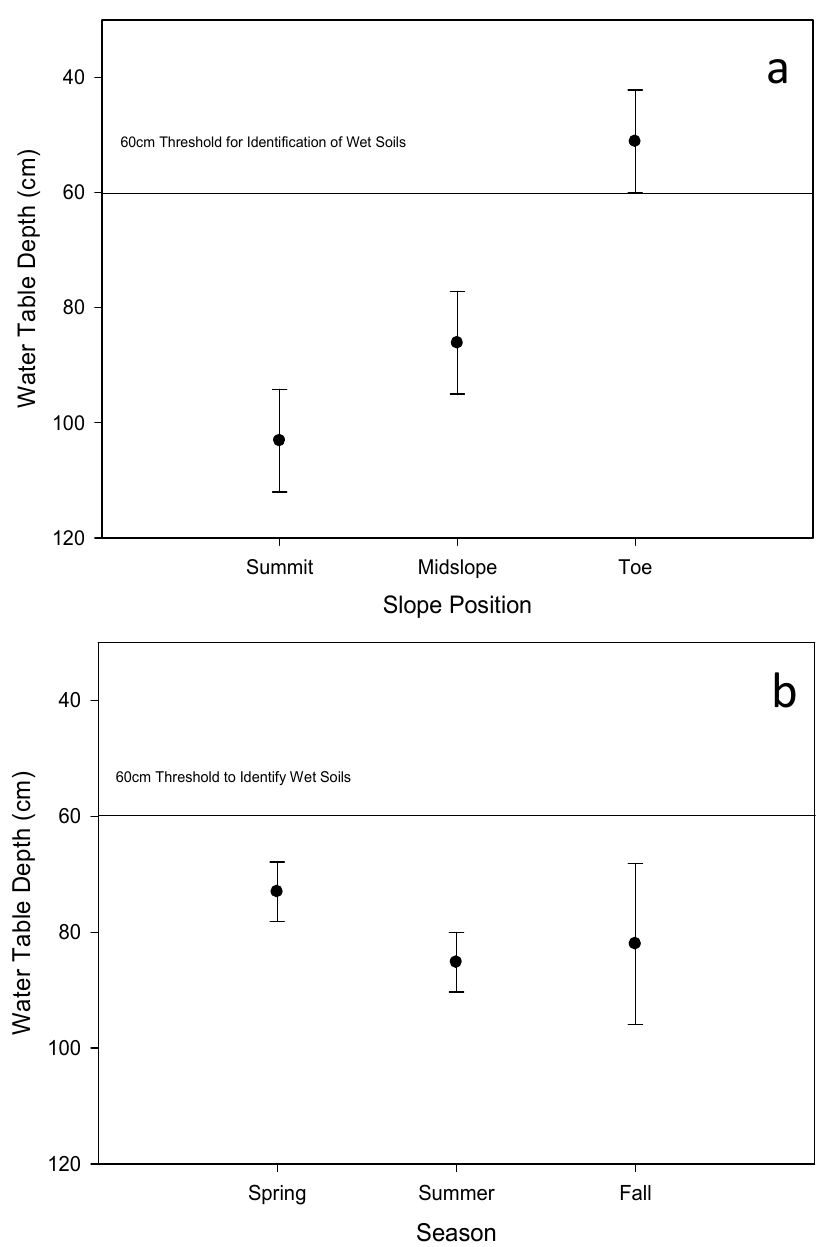
Figure 3. ( a ) Average water table depth at each slope location during 2006 and 2007 (least squares mean and 95% CI, n = 69) and ( b ) average seasonal water table depths at all locations for 2006 and 2007 (least square means and 95% CI, spring and summer n = 84, fall n =